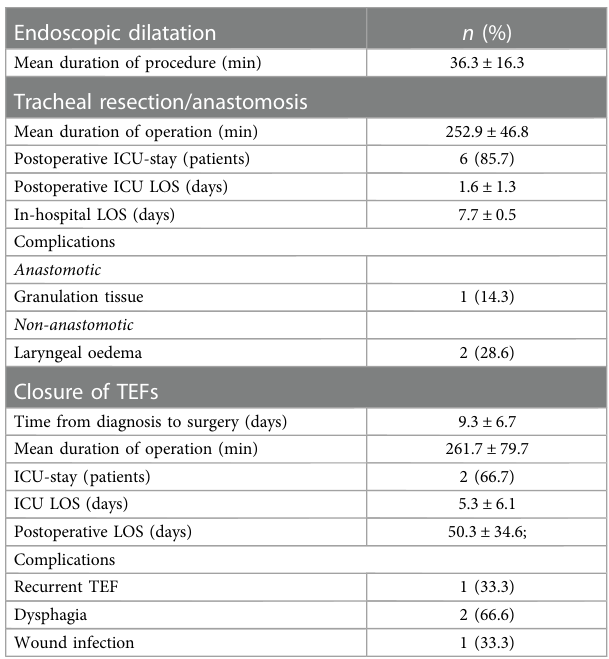
TABLE 3 Intraoperative and postoperative patients ’